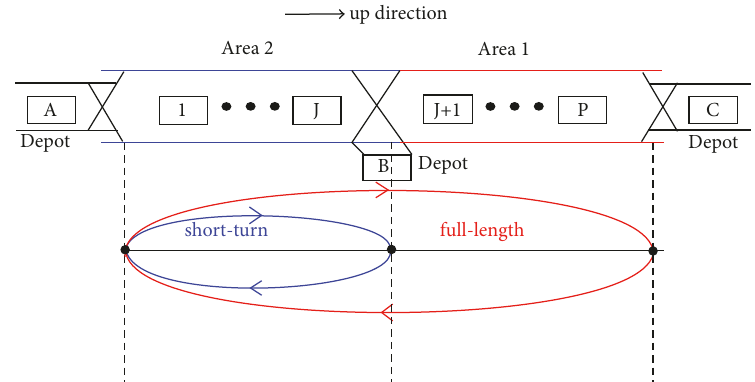
Figure 2: The layout of an urban rail transit